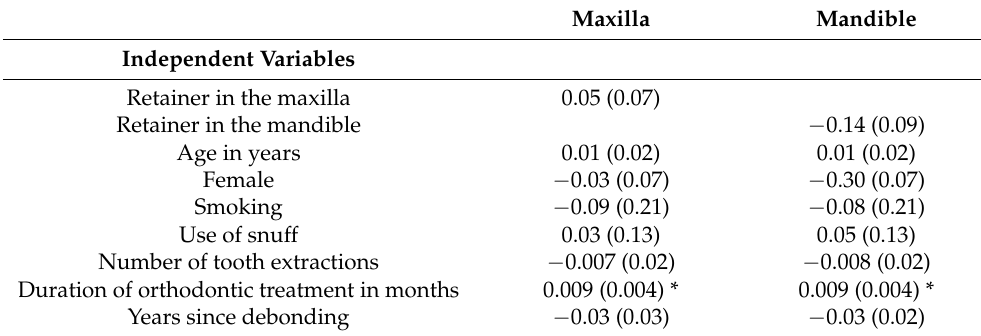
Table 8. Predictors of patient-reported retainer